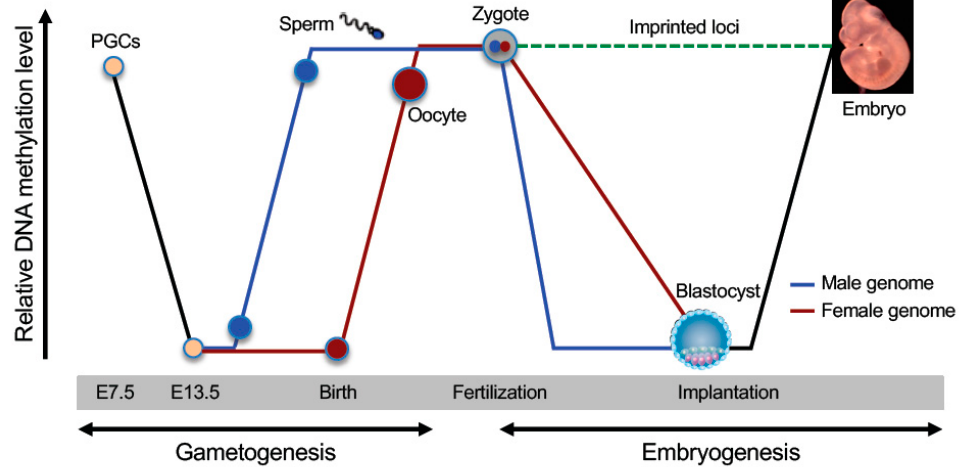
Figure 1. Dynamic changes in DNA methylation during mammalian development. Schematically shown are the two waves of global DNA demethylation and remethylation in the life cycle (adapted from [6]). Primordial germ cells (PGCs) initially have high levels of DNA methylation. Global demethylation occurs during PGC expansion and migration. At later stages of germ cell development (before birth in male and after birth in female), de novo methylation results in the establishment of sex-specific germ cell methylation patterns, including methylation marks at imprinted loci. Shortly after fertilization, the methylation marks inherited from the gametes are erased again (except those at imprinted loci and some retrotransposons), with the paternal genome undergoing active demethylation and the maternal genome undergoing passive demethylation. Upon implantation, a wave of de novo methylation establishes the initial embryonic methylation pattern.